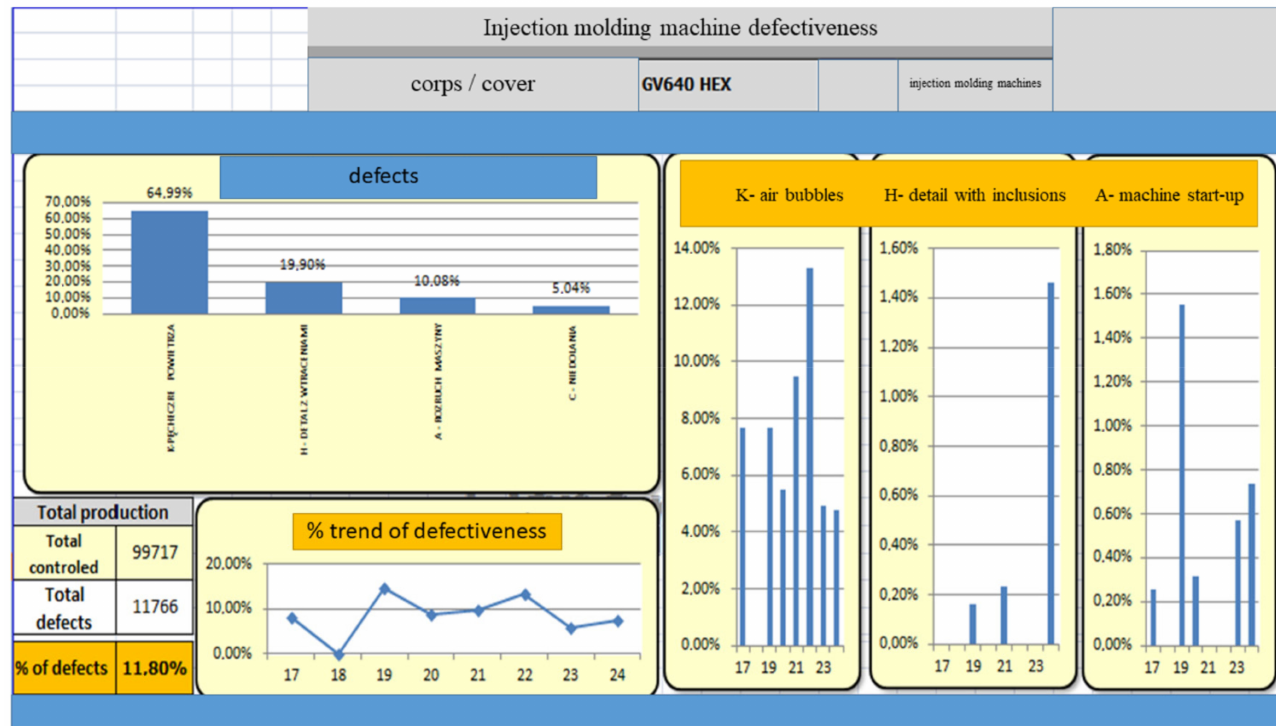
Figure 22. XR card—illustrating the production process of the flow meter detail.